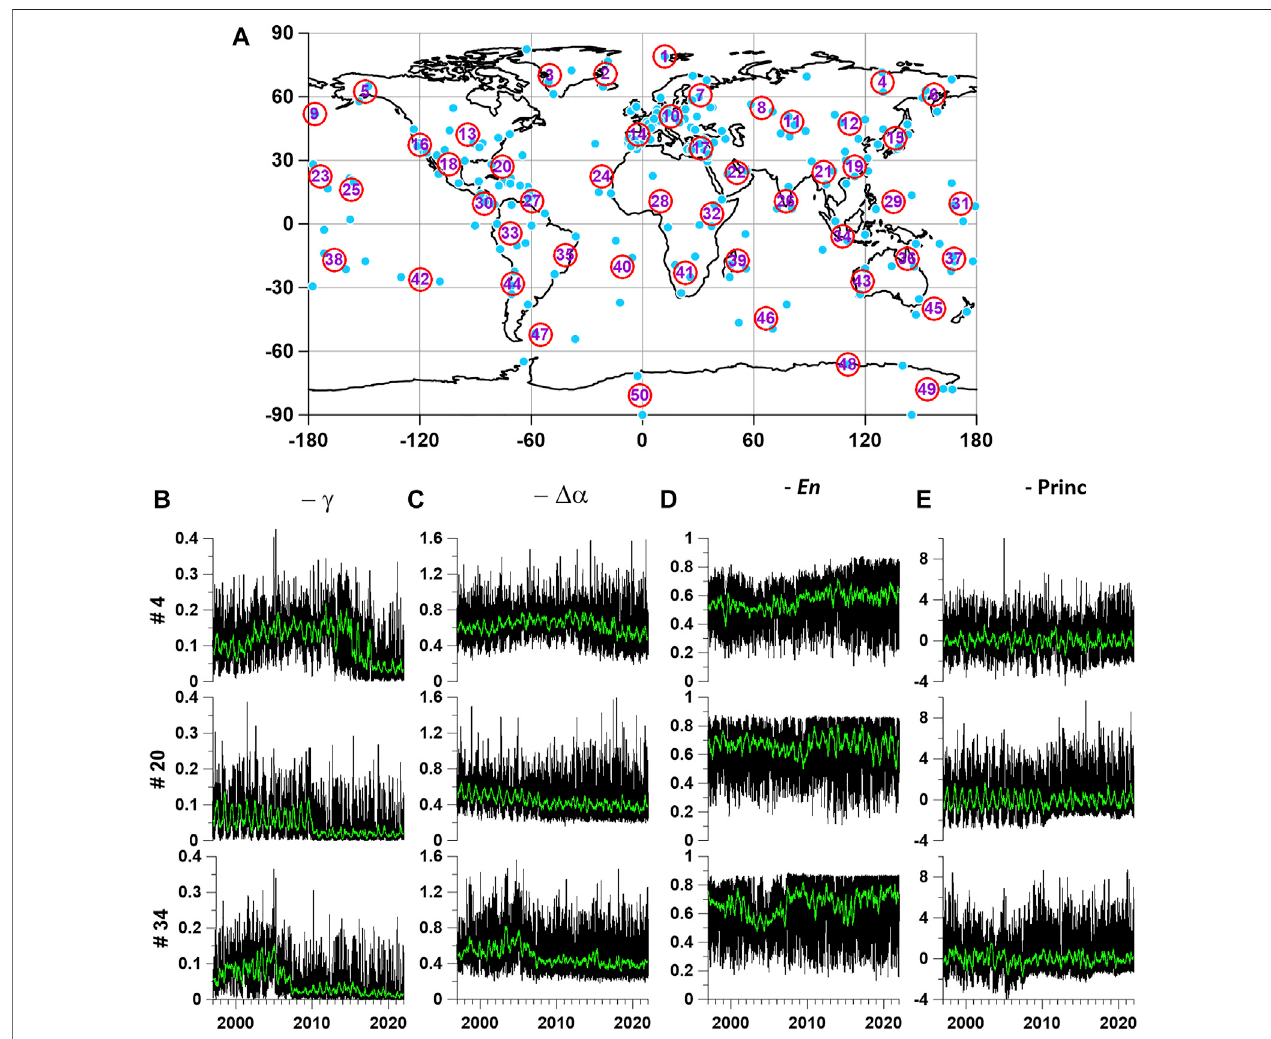
FIGURE 1 | (A) — positions of 229 seismic stations (blue circles) and 50 reference points (numbered red circles); (B – D) — plots of daily values of 3 properties of seismic noise γ , Δ α and En , corresponding to reference points with numbers 4, 20 and 34; (E) — plots of the fi rst principal component of noise properties calculated in a sliding time window of 365 days length for the speci fi ed reference points. The green lines represent moving average graphs in a57-day window. Values of γ , Δ α , En and fi rst principal component are dimensionless.